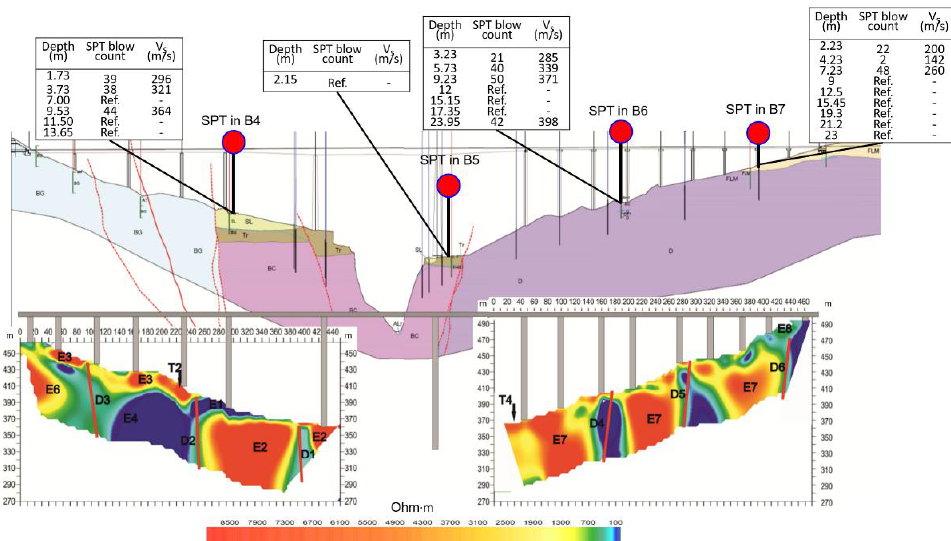
Figure 5. Cross-section of the Lao river valley showing the SPT results; V S values estimated from SPT blow counts using an empirical relationship [19] for B4, B5, B6, and B7; geologic units; tectonic discontinuities (red dotted lines); and ERT1 and ERT3 on the right and left banks of the valley, re-